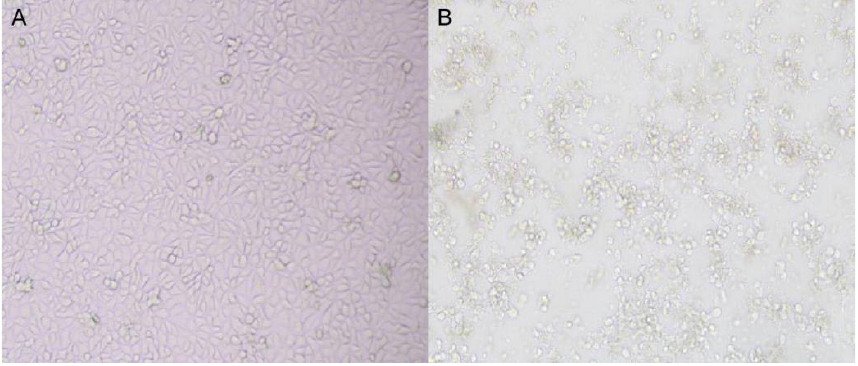
Figure 1. Lesions of Z317 isolate on RK 13 cells at 48 h (100×). ( A ): Normal RK 13 cell line. ( B ): Typical CPE of isolates in the RK 13 cell line.